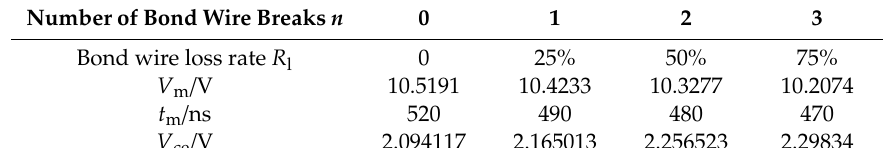
Table 2. Actual value of V m , V ce , and t m at di ff erent IGBT bond wire losses.